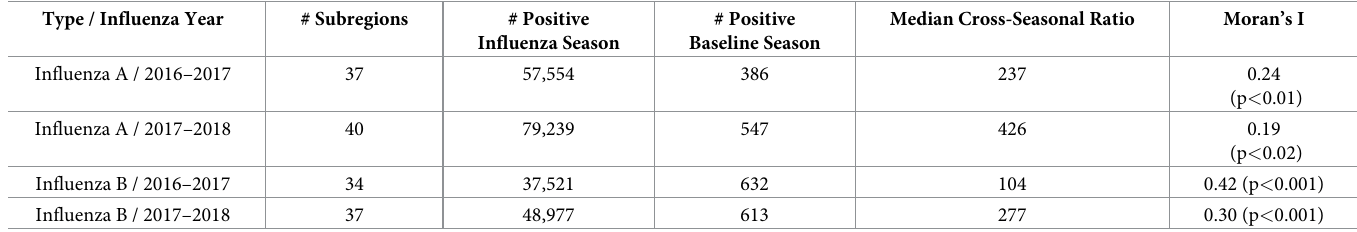
Table 1. Basic summary of the results stratified by year and influenza type. Moran’s I values are similar to correlation coefficients with values typically ranging from -1 to 1 and higher values indicating higher spatial autocorrelation. Type / Influenza